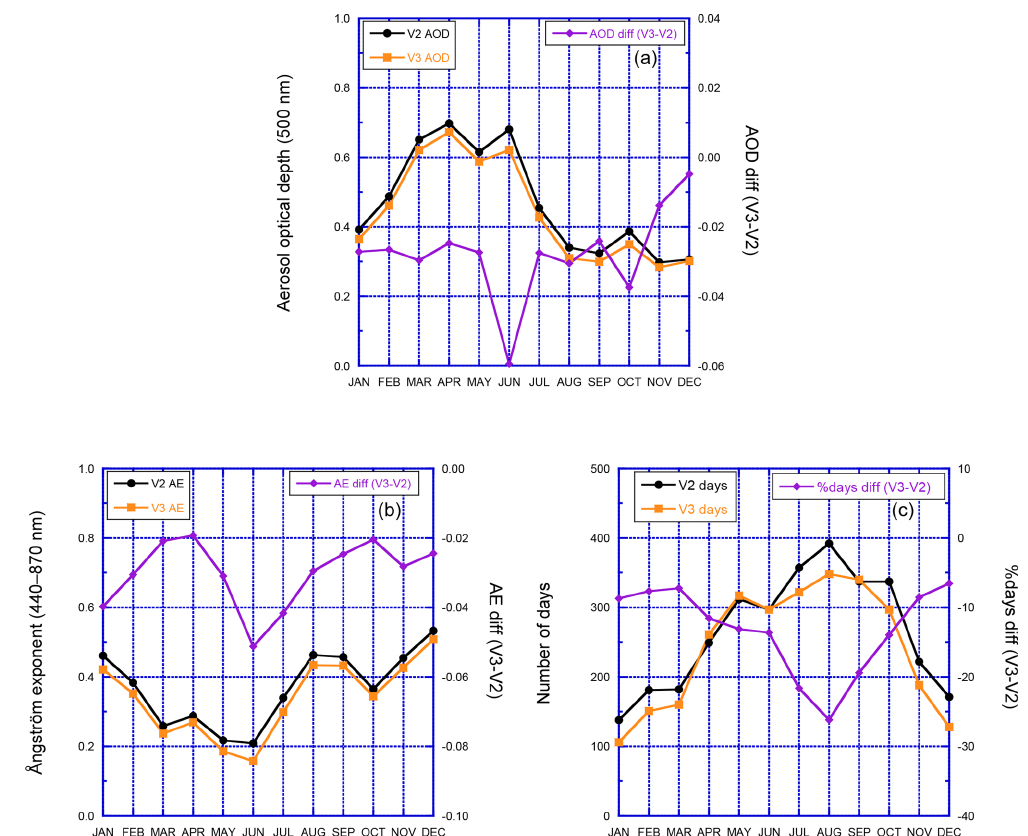
Figure 27. Similar to Fig. 23, except for IER Cinzana, Mali (lat 13.28, long − 5.93), from 2004 to